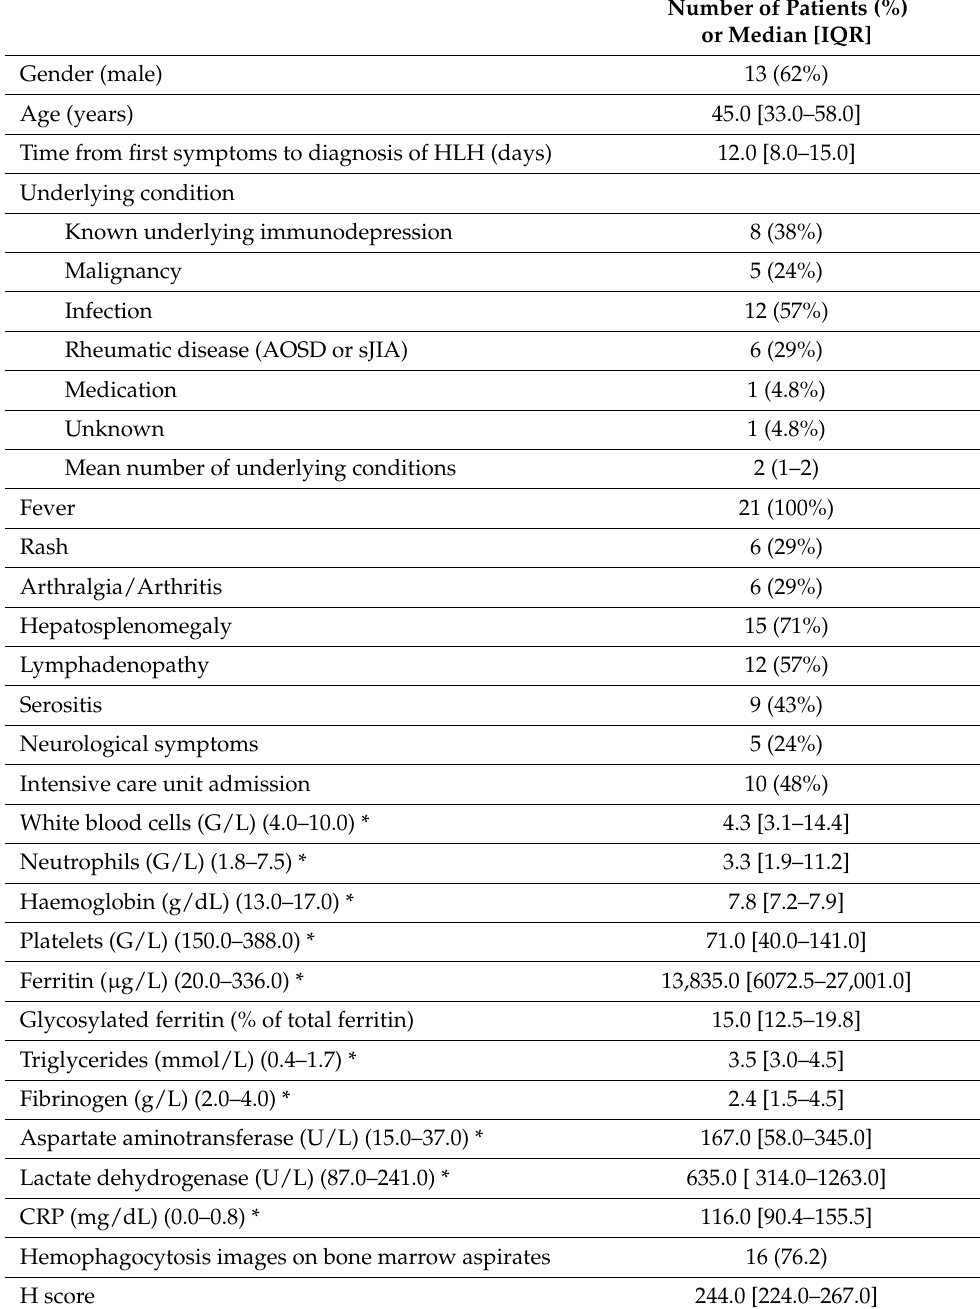
Number of Patients